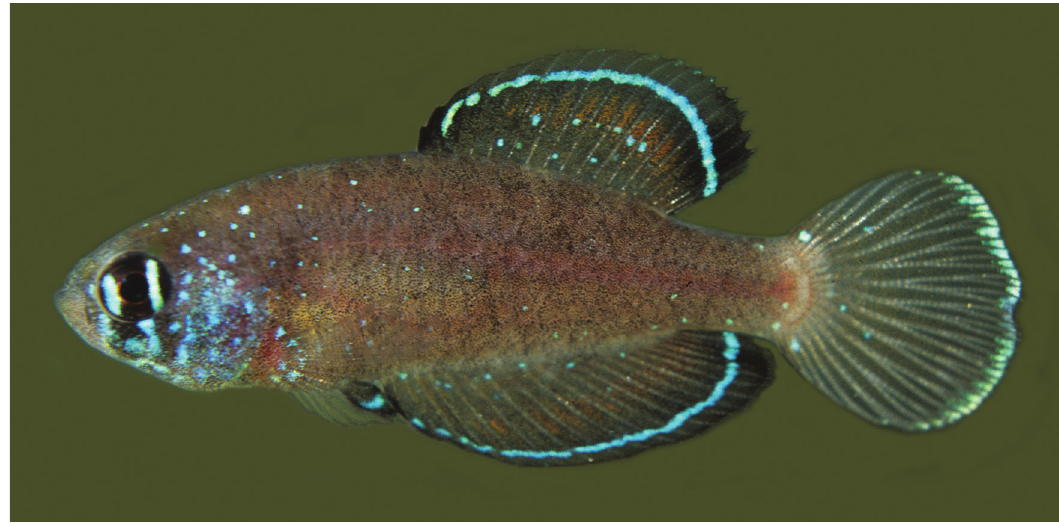
Figure 4. Spectrolebias gracilis sp. n., UFRJ 6440, holotype, male, 19.2 mm SL; Canabrava floodplains.